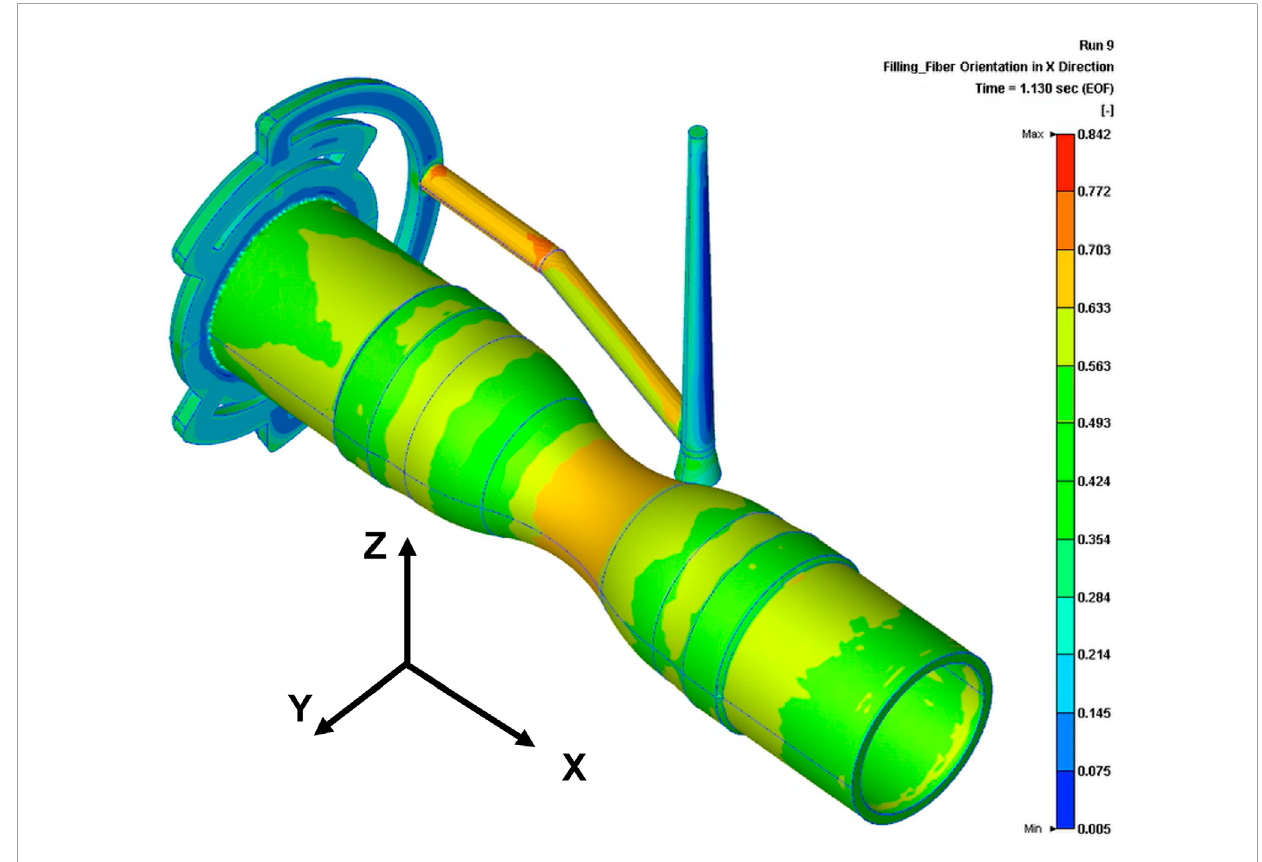
FIGURE 7 Fiber orientation distribution in X-direction (in-flow) at end of filling.